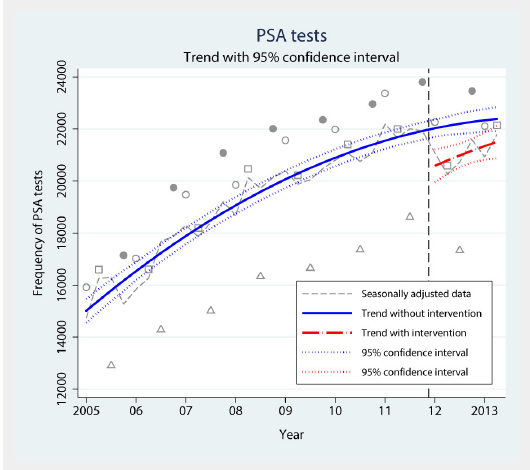
Prostate specific antigen (PSA) tests over time (2005–2013). Each data point represents the number of PSA tests over 3 months in Helsana Insurance (○ JAN-MAR; □ APR-JUN; ∆ JUL-SEP; ● OCT-DEC). The dashed line is corrected for seasonal effects. Vertical dashed line: Time point of SMB report released in 2011. Blue solid trend line: Trend (95% CI) without Swiss Medical board (SMB) recommendations up to 2013. Red solid trend line: Trend (95% CI) after release of SMB recommendations in